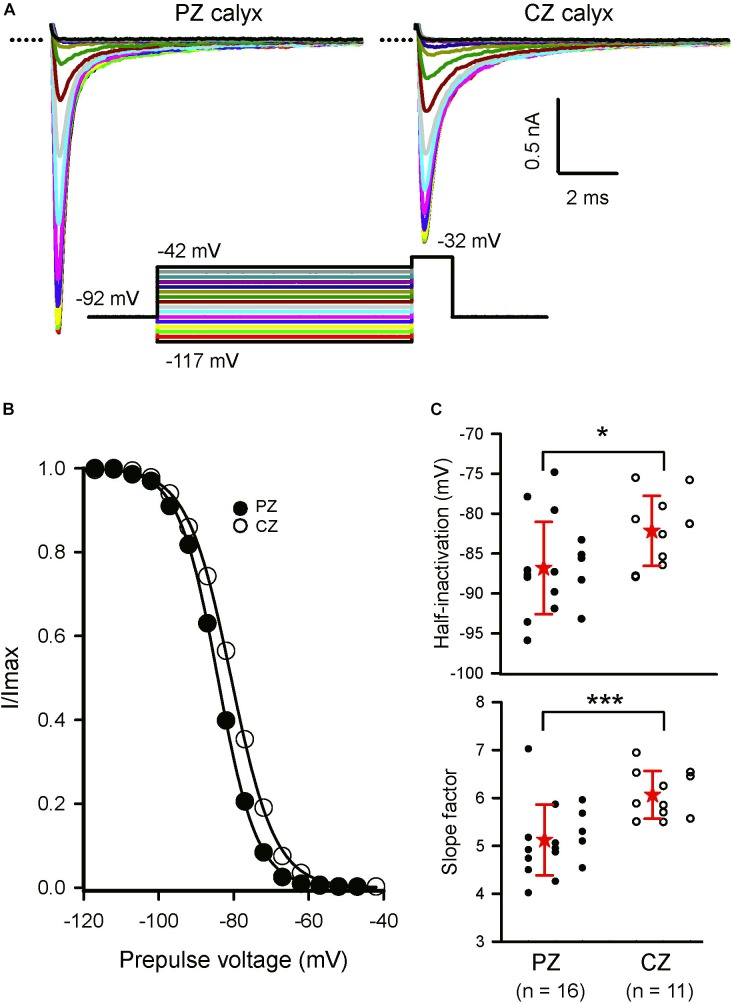
Inactivation of Na+ currents in regionally identified calyces. (A) Inactivation of INa in a PZ (P22) and CZ calyx-only afferent (P25). Currents shown are at a test step to –32 mV. Entire voltage protocol (shown below) consisted of prepulses from a holding potential of –92 mV to potentials between –117 and –42 mV in 5 mV increments before the test step. The largest currents were evoked following the most negative prepulses. (B) Currents were normalized to maximum inward current, plotted as a function of prepulse voltage and fit with a Boltzmann curve (Eq. 1). V1/2 inactivation was –84.2 mV in the PZ cell and –80.7 mV in the CZ cell. Slope factor was smaller in the in the PZ calyx (5.2) compared to the CZ calyx (5.9). (C) Mean V1/2 inactivation and slope values are compared for calyces from the two different zones. Dots represent individual calyx responses, stars the mean, and error bars the standard deviation of the mean. Mean half-inactivation in PZ calyces was –86.8 (5.8) mV (n = 16), significantly more hyperpolarized than in CZ calyces [–82.2 (4.4); n = 11; P = 0.024, t-test]. Mean slope factor in PZ calyces was 5.1 (0.7) (n = 16), significantly less than the value of 6 (0.5) in CZ calyces (n = 11; P < 0.001, t-test). ∗P < 0.05, ∗∗∗P < 0.001. Numbers below plots indicate number of cells for each group. External solution was 0 K+ and contained either 80 mM Na+ or 150 nM Na+. Electrode solution was Cs+-based.